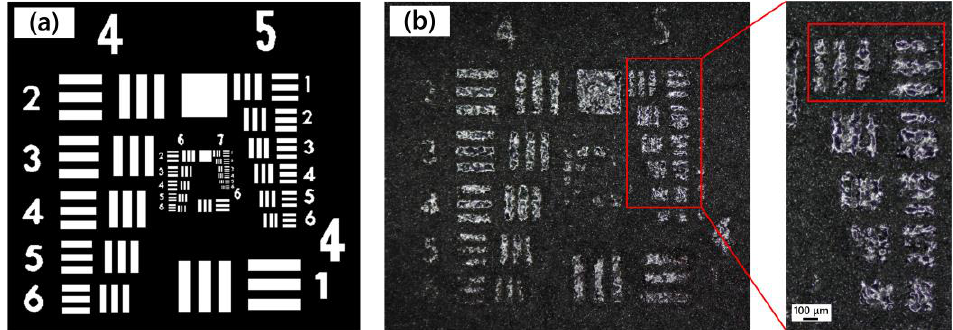
Figure 7. ( a ) Resolution pattern image loaded on the OASLM. ( b ) The printing results of the resolution pattern image.